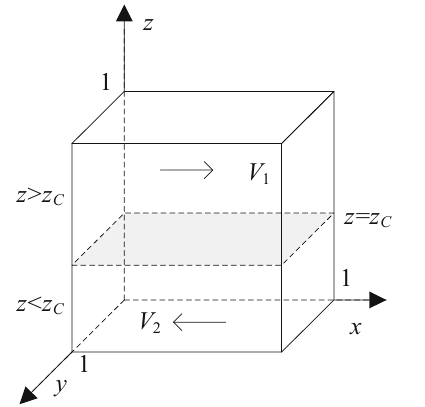
Fig. 2 Dynamic trend diagram for the freight